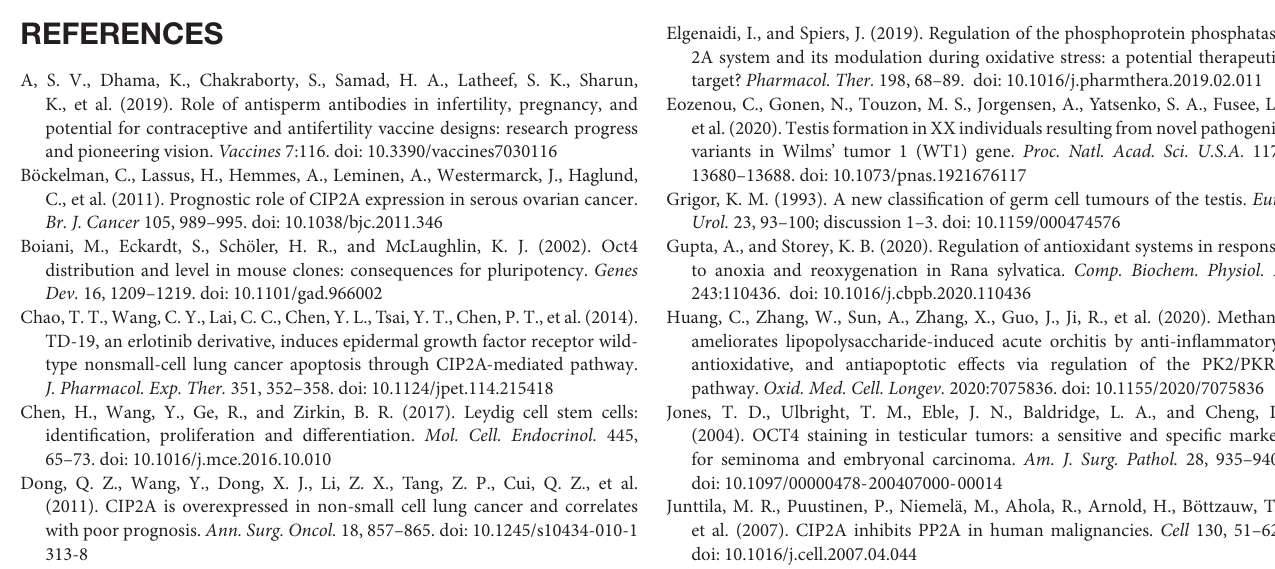
Supplementary Figure 1 | Effects of the redox response on cell apoptosis in LPS-induced Sertoli, Leydig, and germ cells. Leydig, Sertoli, and germ cells incubated with LPS and/or paraquat (5 µ M)/NAC (50 µ M) for 12 h. (A–C) The DHE assay was carried out to detect the ROS generation in the cells. (D–F) The apoptotic cell count was evaluated using Annexin V-FITC/PI flow cytometry analysis and is displayed in the right quadrant in each plot. The apoptotic rates of each cell type are presented in the lower panel. Data are expressed as the means ± SDs. ∗ P < 0.05, ∗∗ P < 0.01, Ctrl vs. LPS + vehicle; # P < 0.05, ## P < 0.01, LPS + paraquat or NAC vs. LPS +